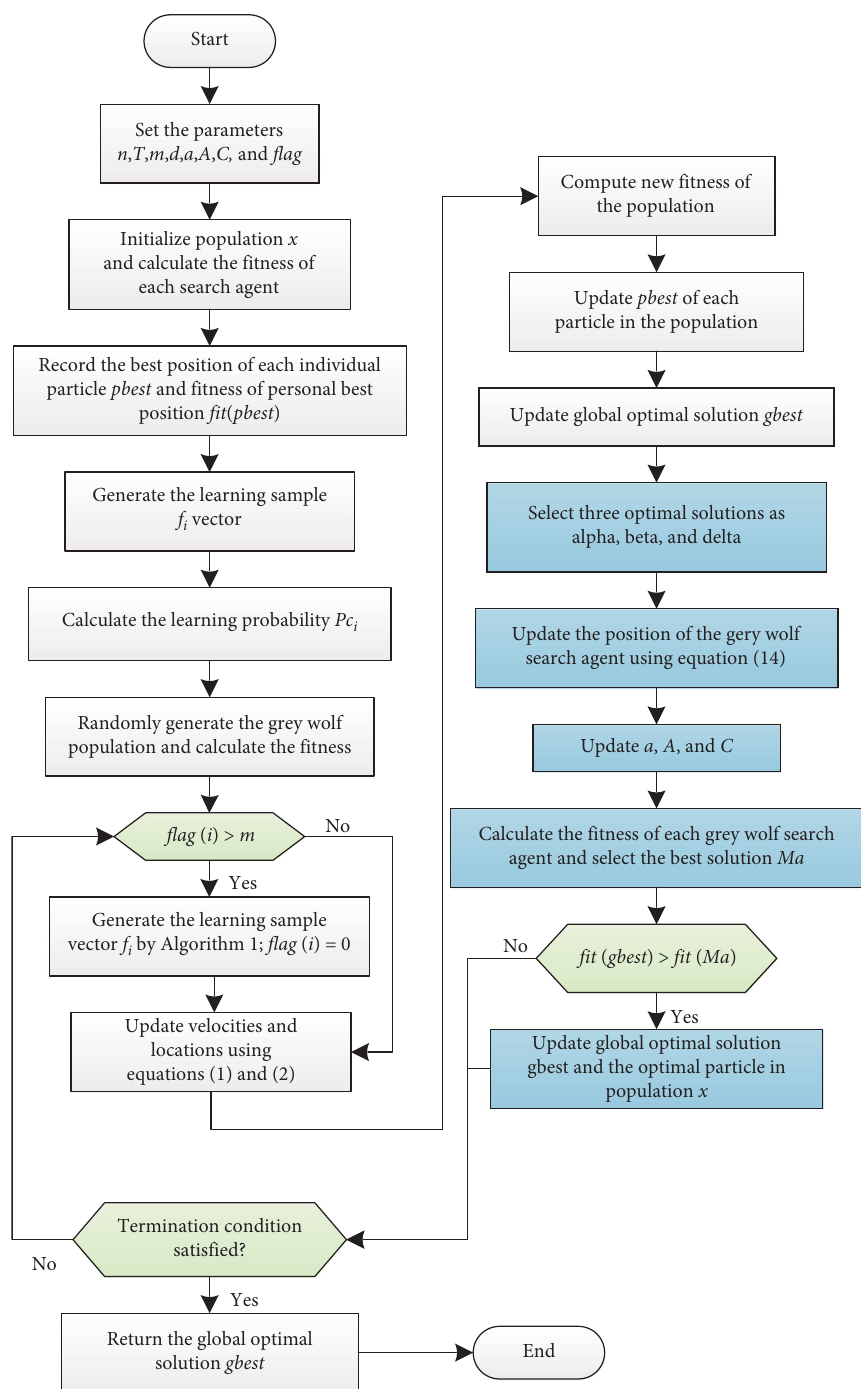
Figure 1: Flowchart of the